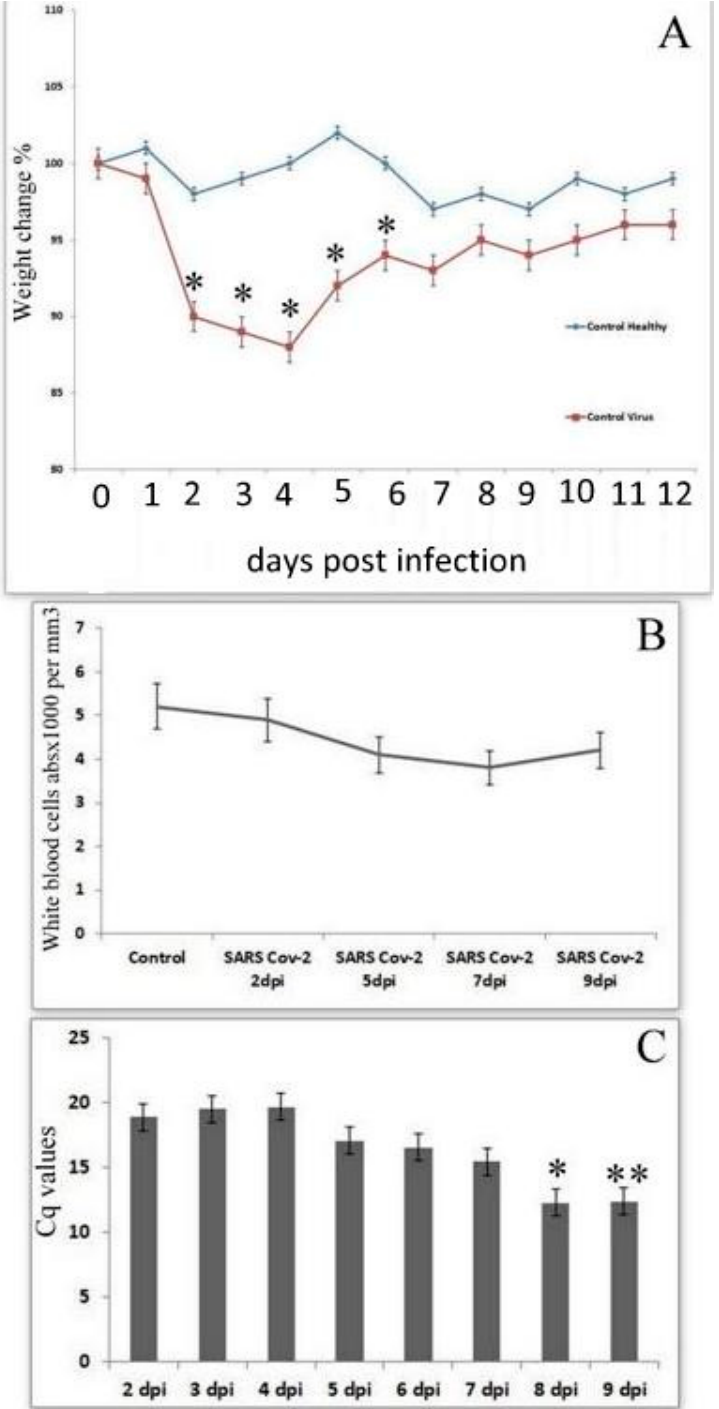
Figure 7. Physiological indices and virus presence in SARS-CoV-2 infected hamsters. ( A ) Dynamics of the body weight in SARS-CoV-2 infected hamsters. ( B ) Dynamic in absolute number of white blood cells in SARS-CoV-2 infected hamsters. ( C ) Viral load in oronasal swabs during SARS-CoV-2 infection in Syrian hamsters. * Significant compared with corresponded titers from groups treated with nucleotide analogues ( p < 0.05– p < 0.01), ** tendency ( p <